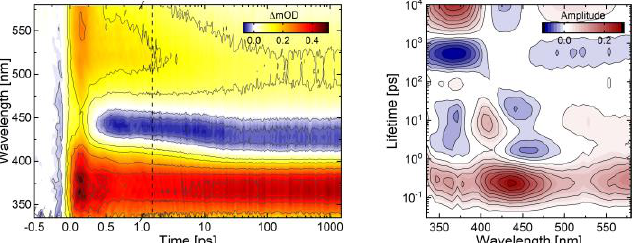
Fig. 3. Transient absorption data ( left ) and LDM ( right ) illustrating the ultrafast dynamics of ( Z,Z )-CB A after ππ* band